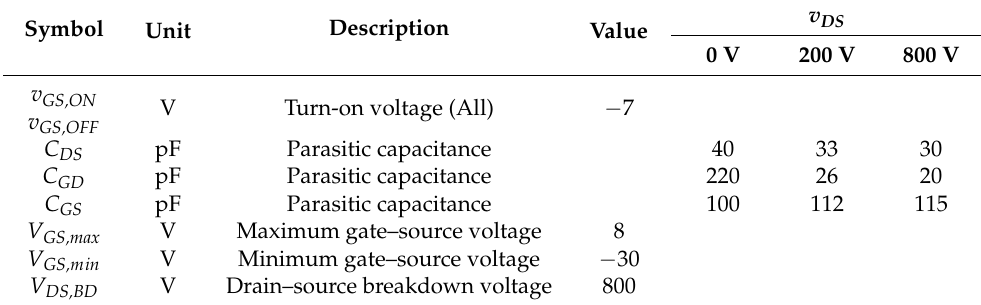
Table 1. Characteristics summary of the D-mode GaN HEMT under 1 MHz switching.